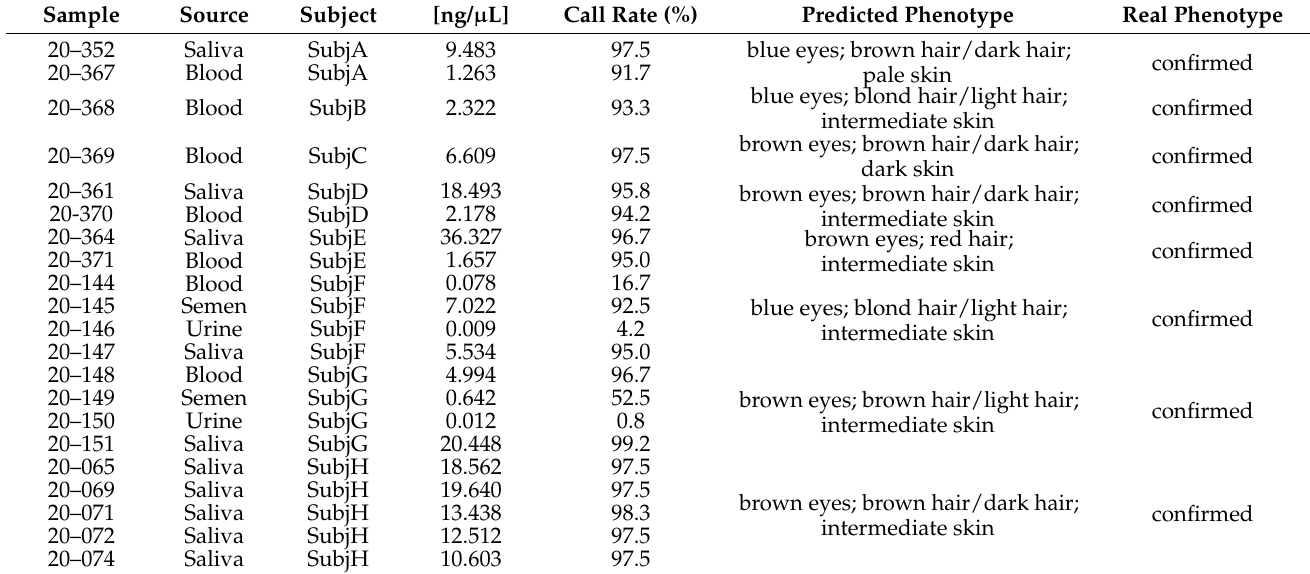
Table 2. Details of forensic biological samples. Subject A (SubjA), Subject B (SubjB), Subject C (SubjC), Subject D